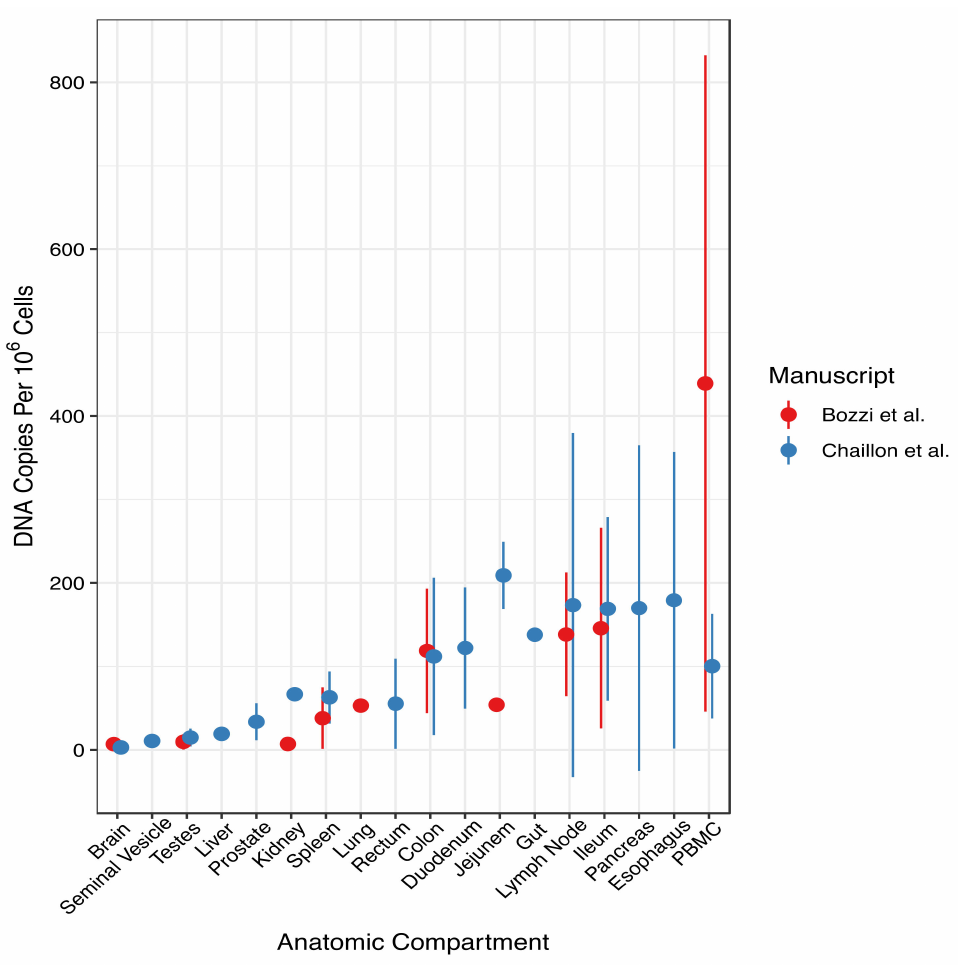
Figure 6. HIV DNA by Anatomic Compartment. This figure depicts copies of HIV DNA-per-million cells quantified by ddPCR at various anatomic sites, as described by two research groups. HIV DNA serves as an estimate of the number of proviruses present. A total of 10 individuals are represented in this figure, 8 of whom had undetectable plasma viral RNA until death and 2 of whom discontinued ART in the days or weeks before death. Each dot represents mean HIV DNA copies across all participants in that study at each anatomic site, with bars that extend to one SD above and below the mean value. Dots that do not have SD bars represent data from one individual, and thus SD could not be calculated. Data are from Bozzi et al. [3] and Chaillon